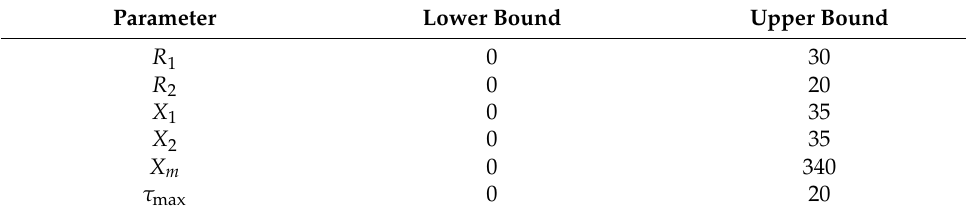
Table 2. Range of all